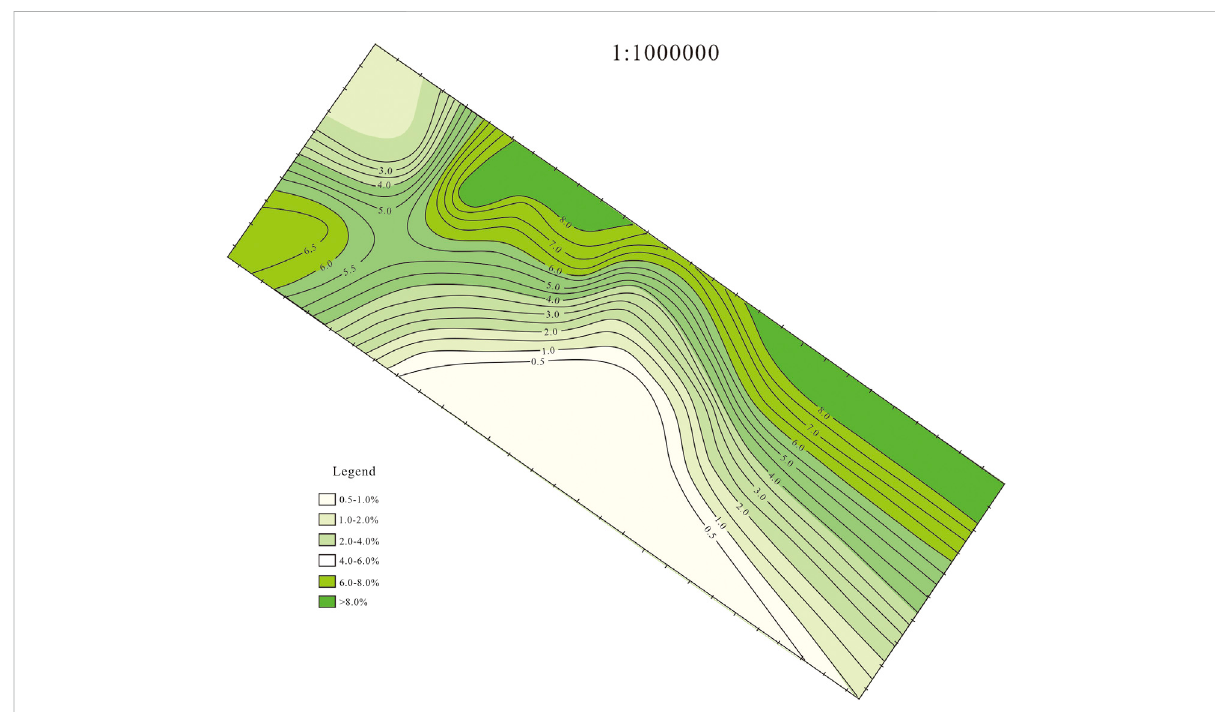
FIGURE 5 Distribution of the TOC content in the source rocks of the Lucaogou Formation.